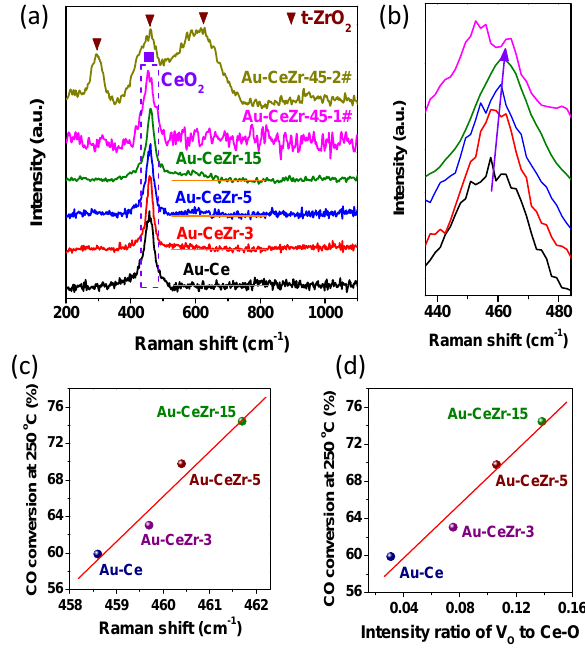
Figure 4. ( a ) Raman spectra of various Au-CeO 2 -ZrO 2 catalysts; ( b ) Magnification of the region around 460 cm − 1 (the dotted rectangle in ( a )); CO conversion at 250 °C (%) vs. Raman shift of Ce-O ( c ) and the Raman intensity ratio of oxygen vacancies (V o ) to Ce-O ( d ).